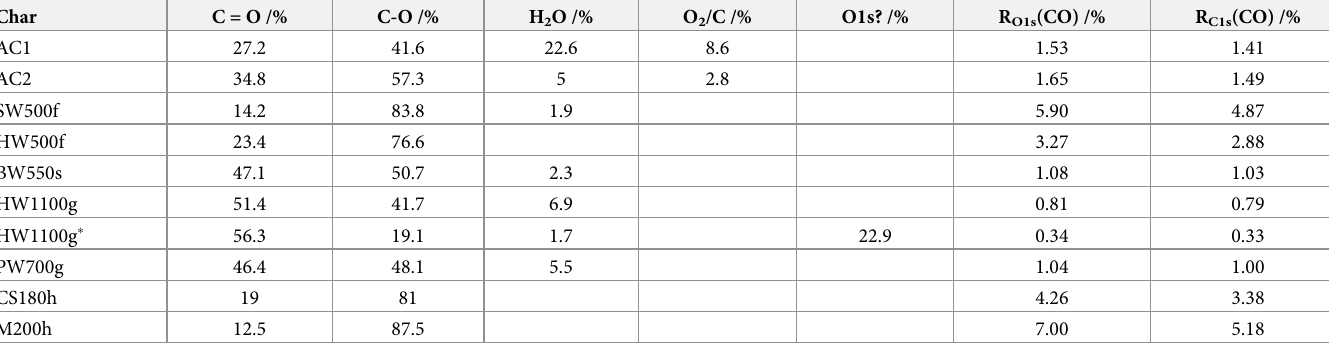
Table 8. XPS of O1s at the surface of ground chars and sample HW1100g � without pretreatment. Char C = O